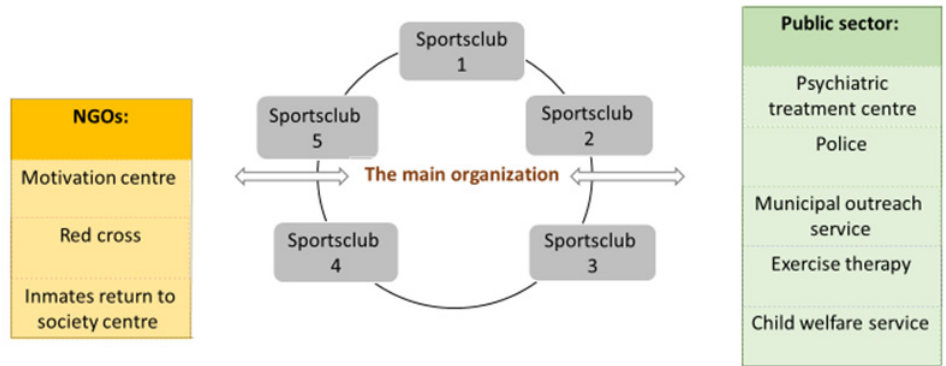
Figure 2. Illustration of the partners of the sports project.